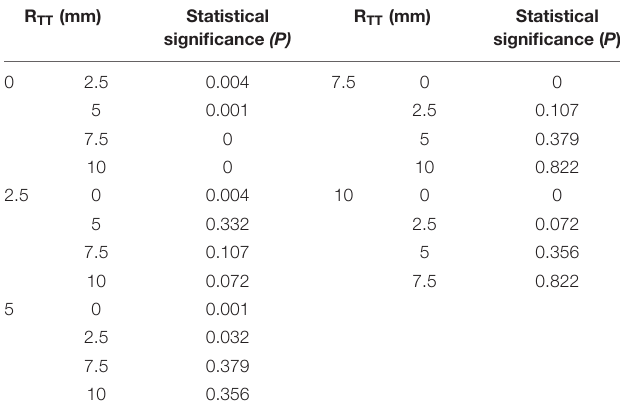
TABLE 3 | Multiple comparison single